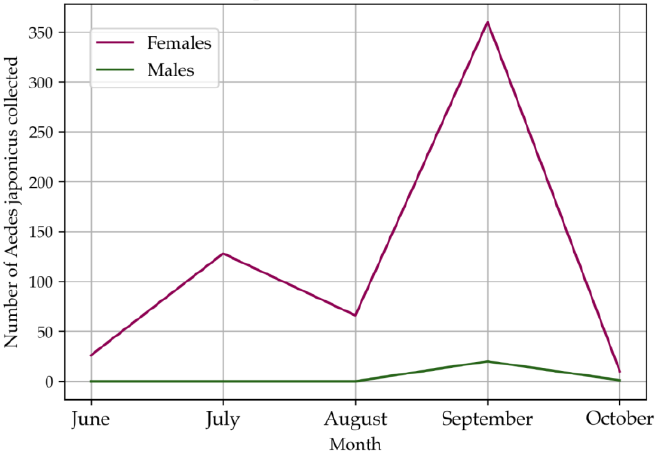
Figure 3. Changes in the abundance of Ae. japonicus according to sampling months. The total number of mosquitoes collected each month in 2021, regardless of the location, was included in this figure. The combined counts for all trap types were used to generate this figure.